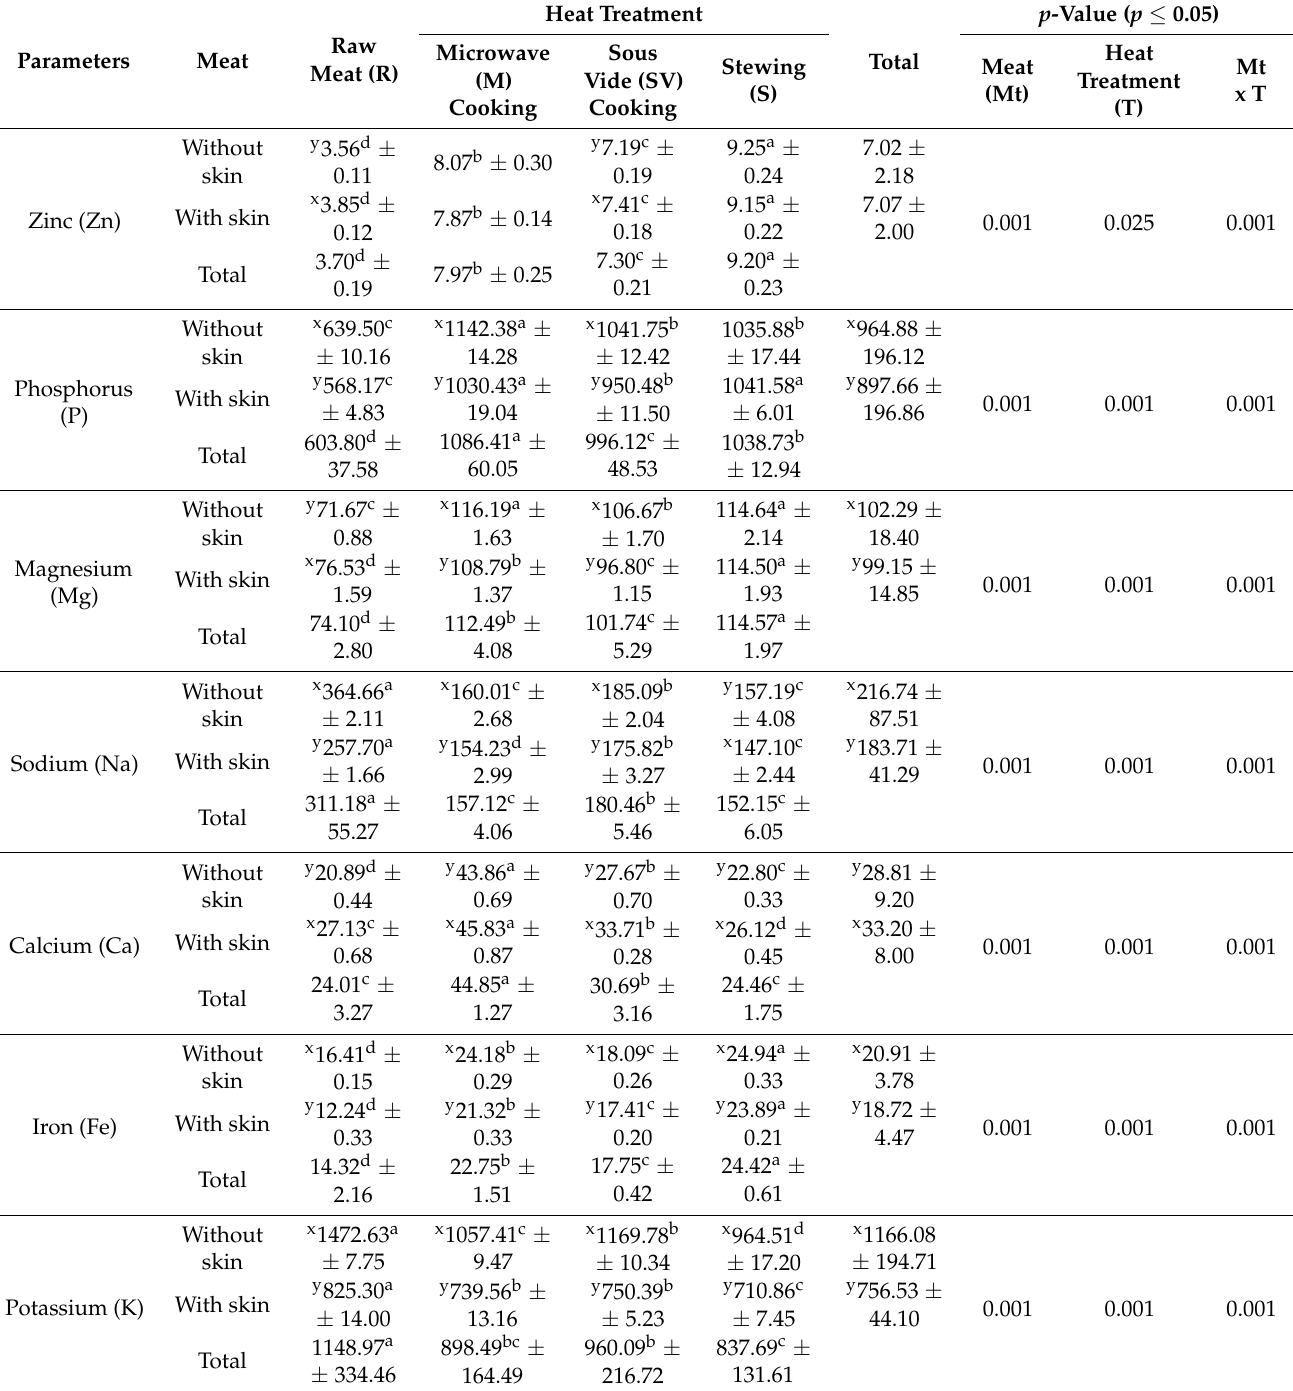
Table 2. Mineral concentration in raw and cooked goose meat (mg/100 g DM) (n = 6 breast muscles with skin and n = 6 without skin for each kind of heat